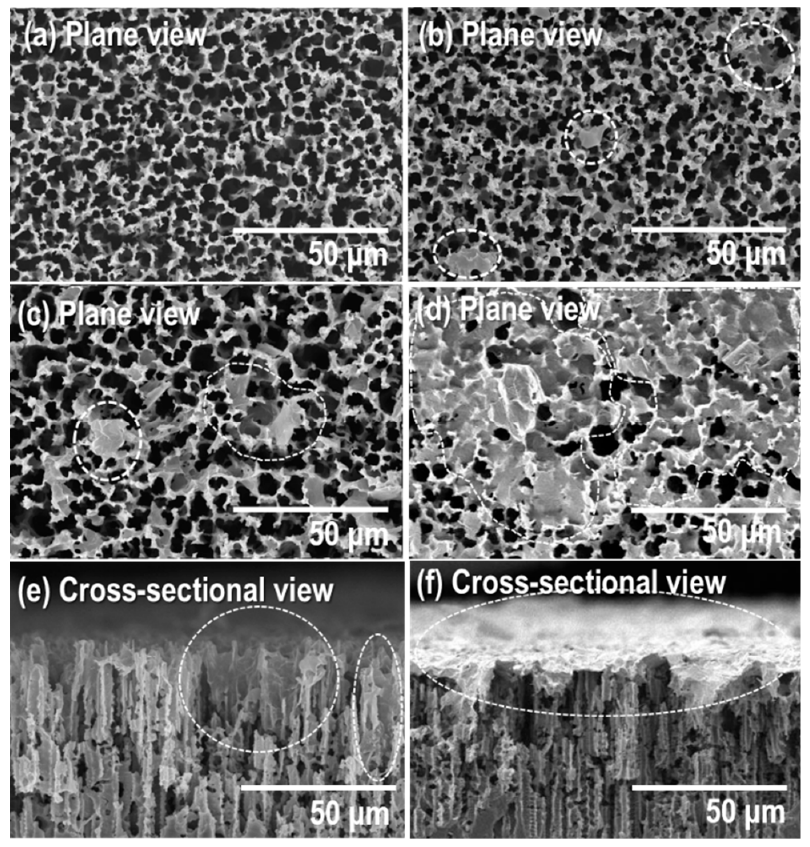
Figure 1. Plane and cross-sectional SEM images of the G-doped/p-Si with ( a ) 0 ( b ) 0.1( c , e ) 1 and ( d , f ), 10 mg/mL graphene solution concentrations.